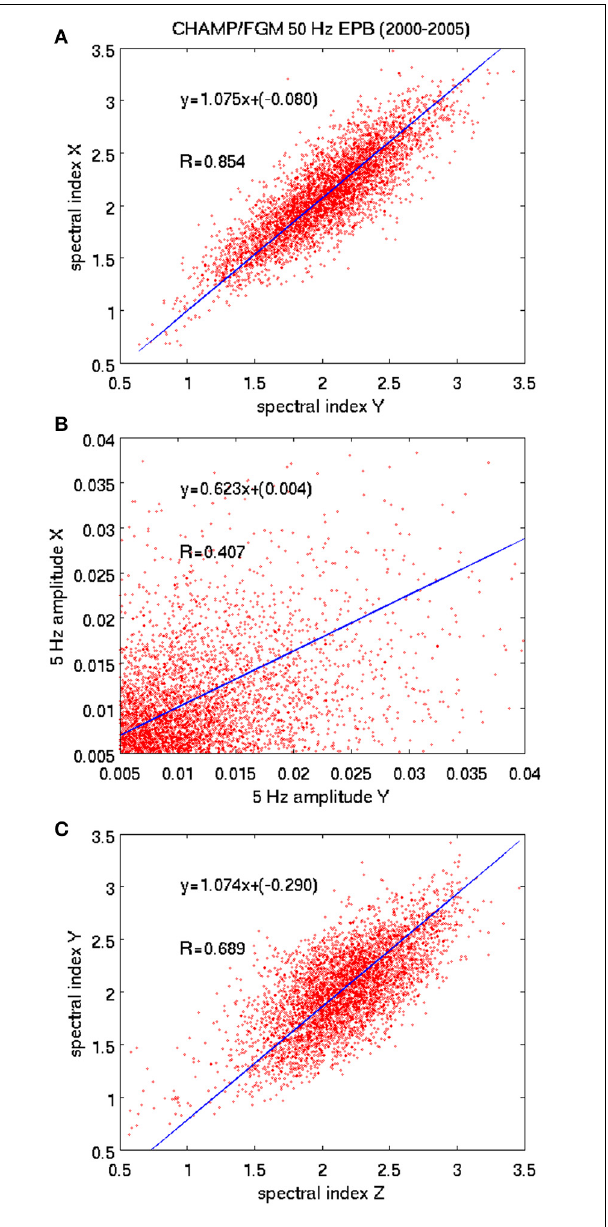
FIGURE 4 | Spectral properties of the three magnetic field components. (A) The two transverse components have almost the same spectral slopes for all events (high correlation and linear slope close to 1); (B) The amplitude ratio between the zonal and meridional component is varying over a wide range; (C) There exists an appreciable correlation between the spectral indices of the parallel and zonal